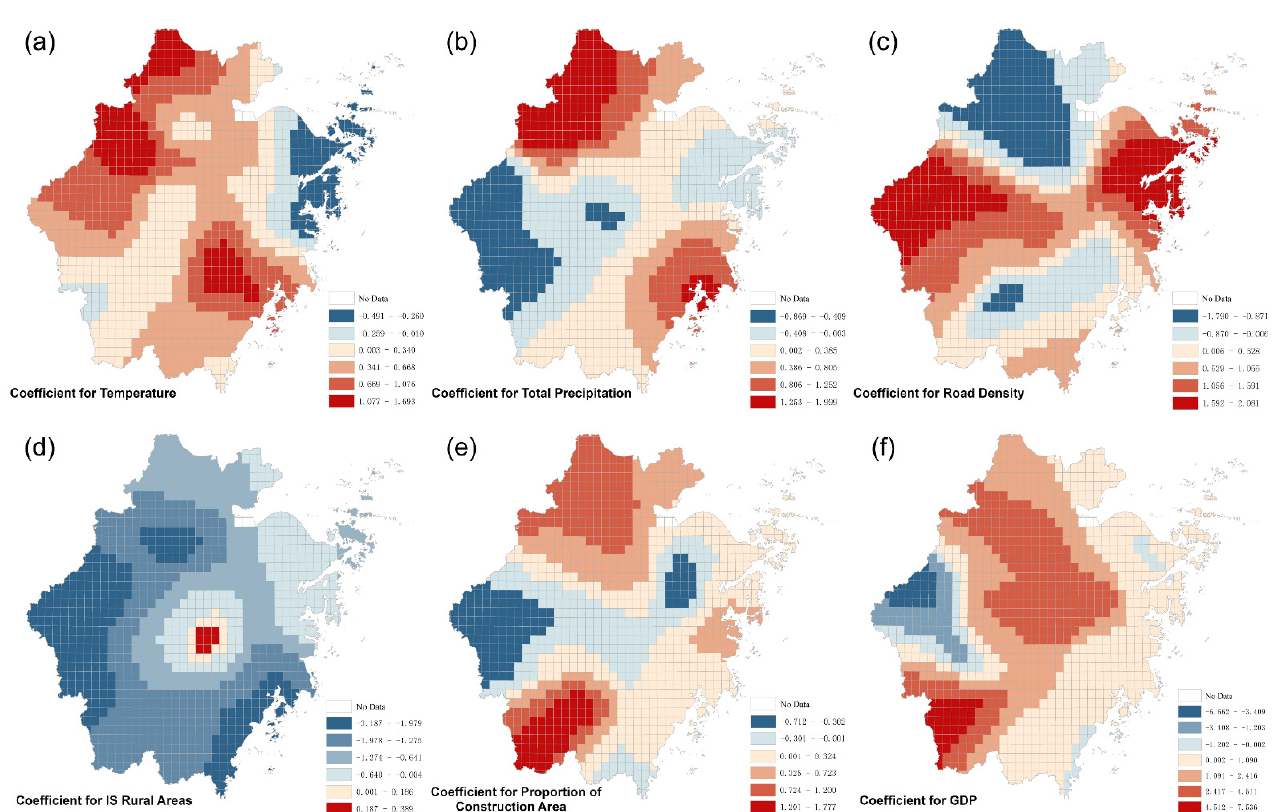
Figure 3. Spatial variation of regression coefficients in geographically weighted logistic regression model, including ( a ) temperature, ( b ) total precipitation, ( c ) road density, ( d ) dummy variable for rural areas, ( e ) proportion of construction area, and ( f ) GDP.